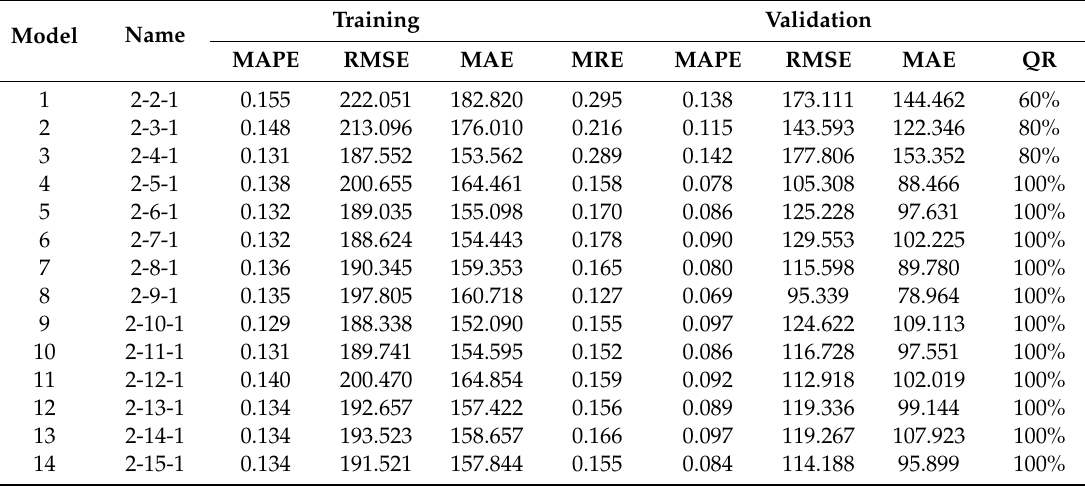
Table 5. With the first and second principal components as input, the performance of Elman networks with di ff erent hidden layer